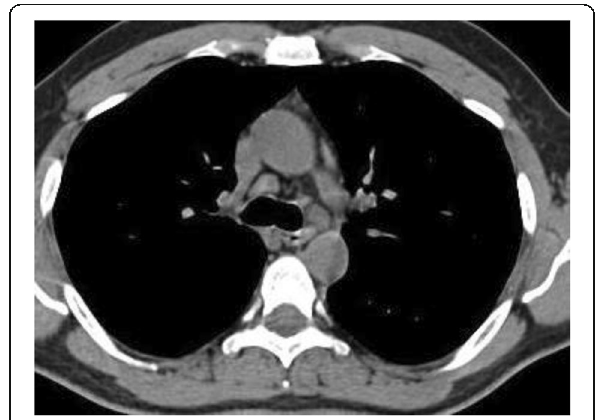
Fig. 23 Enlarged mediastinal lymph nodes in patient with